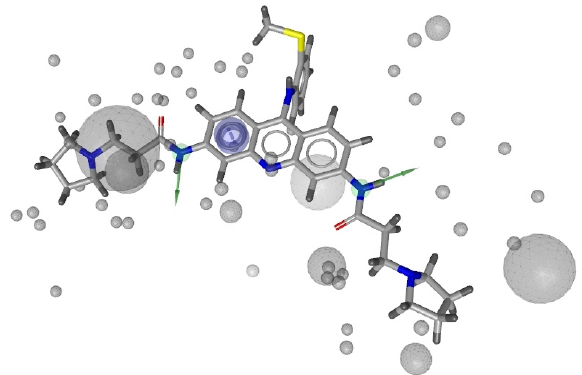
Figure 1. representation of the pharmacophore H_2 generated starting from 3CE5 PDB model by LigandScout software.